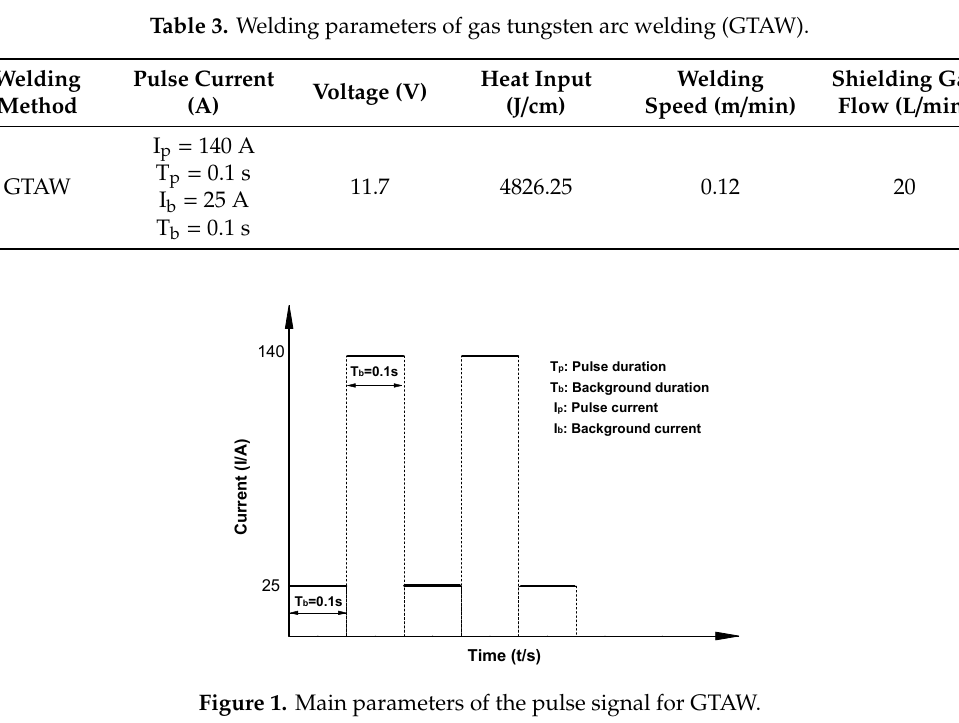
Figure 2. Schematic of the uniaxial tensile test sample of ( a ) welded joints and ( b ) hardening zone (HZ).